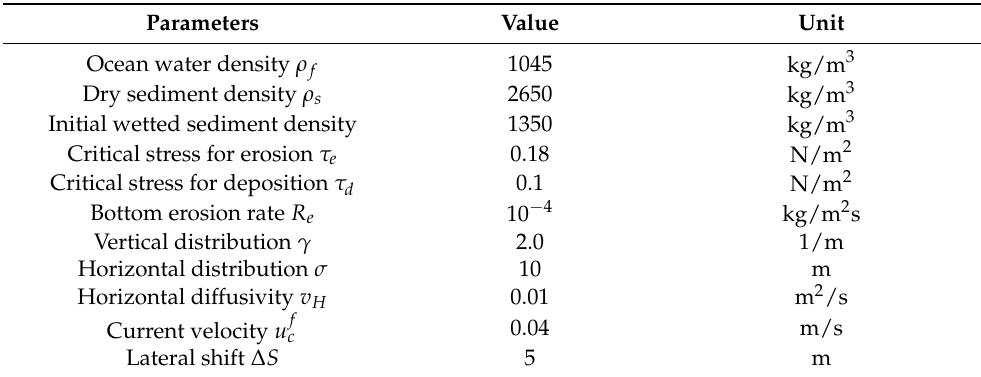
Table 1. Parameters used in the